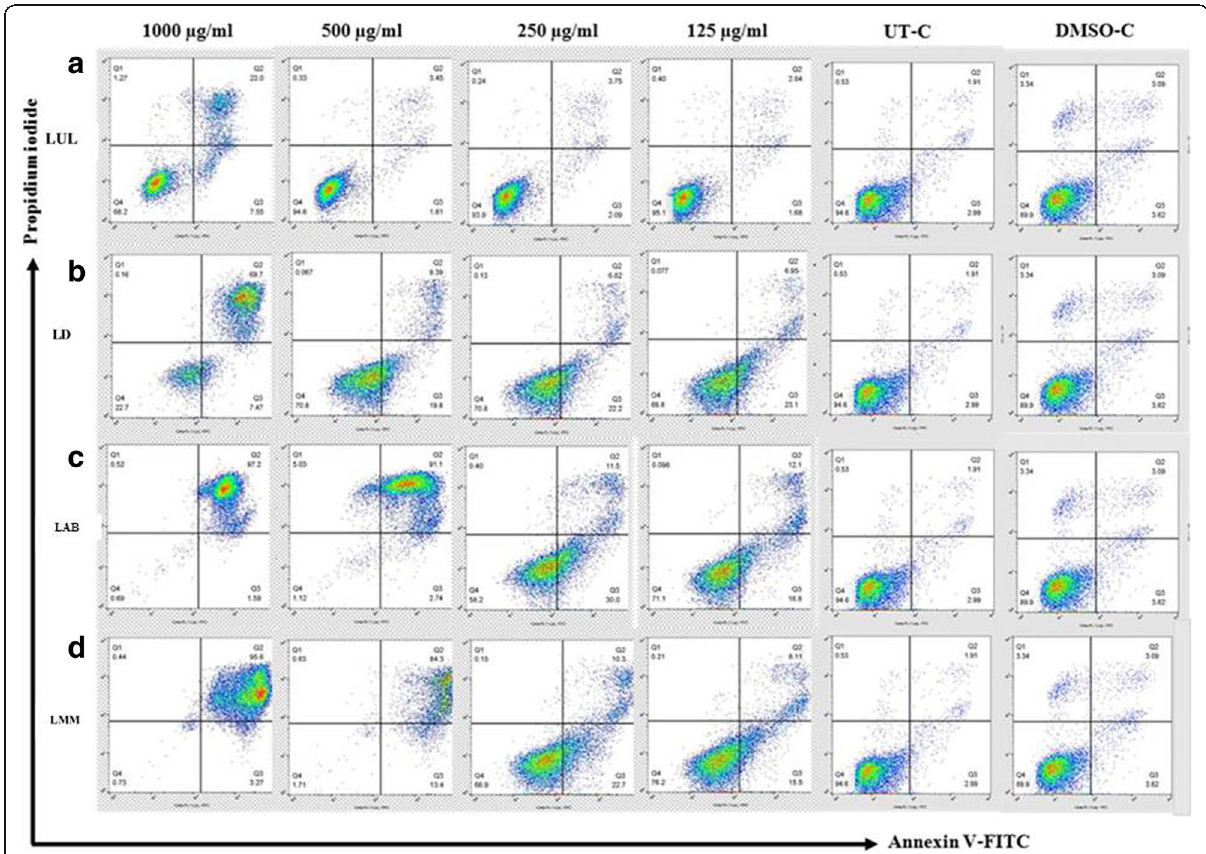
Fig. 1 Effect of crude extracts from the leaves of U. longipes a , Dasymaschalon sp. b , A. burmanicus c , and M. modestum d on the induction of apoptosis in the sample RAJI cell. RAJI cells were cultured in the presence of various concentrations of the crude extracts for 24 h. The cells were then stained with Annexin V and PI, and analyzed by flow